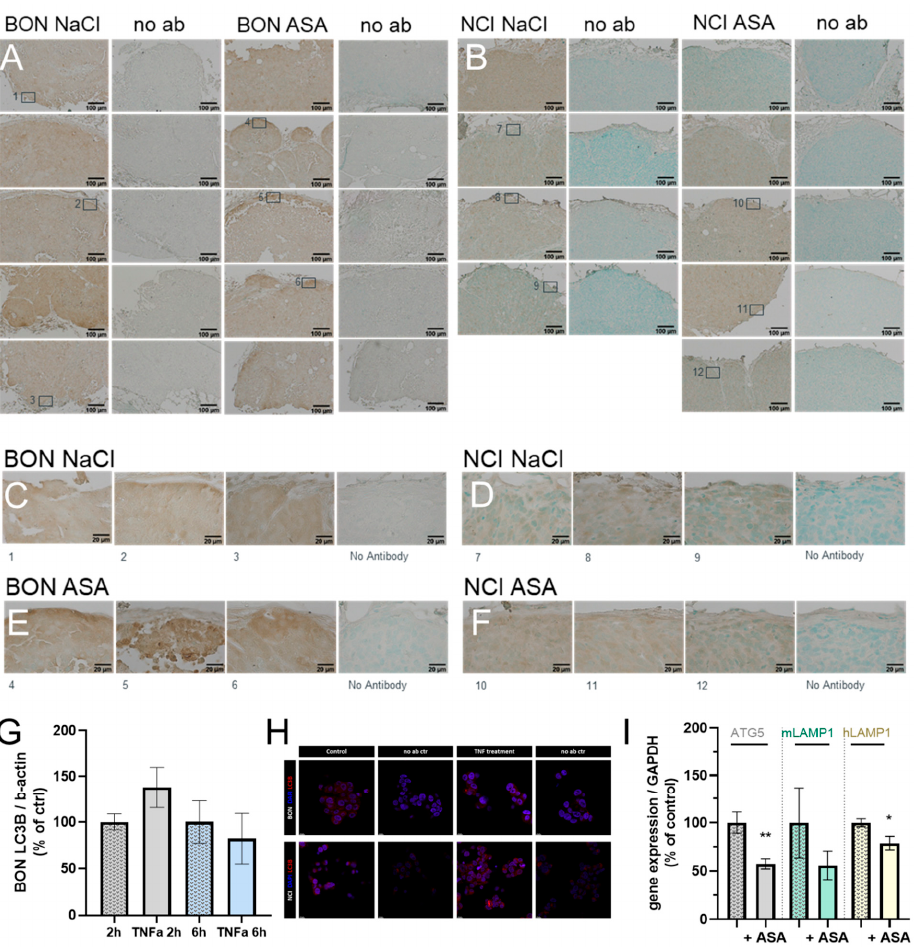
Figure 5. LC3B immunohistochemistry of NaCl- and ASA404-treated BON ( A , C , E ) and NCI-H295R ( B , D , F ) tumors. LC3BI Quantification of TNF α -treated BON tumor cells by western blot ( G ) and LC3B visualization by immunofluorescence in vitro ( H ). ATG5, murine LAMP-1, and human LAMP-1 gene expression analysis in NaCl- and ASA404-treated BON tumors in vivo ( I ). The statistical significance is based on paired t -tests vs. controls and is denoted as stars (* p < 0.05; ** p < 0.01).